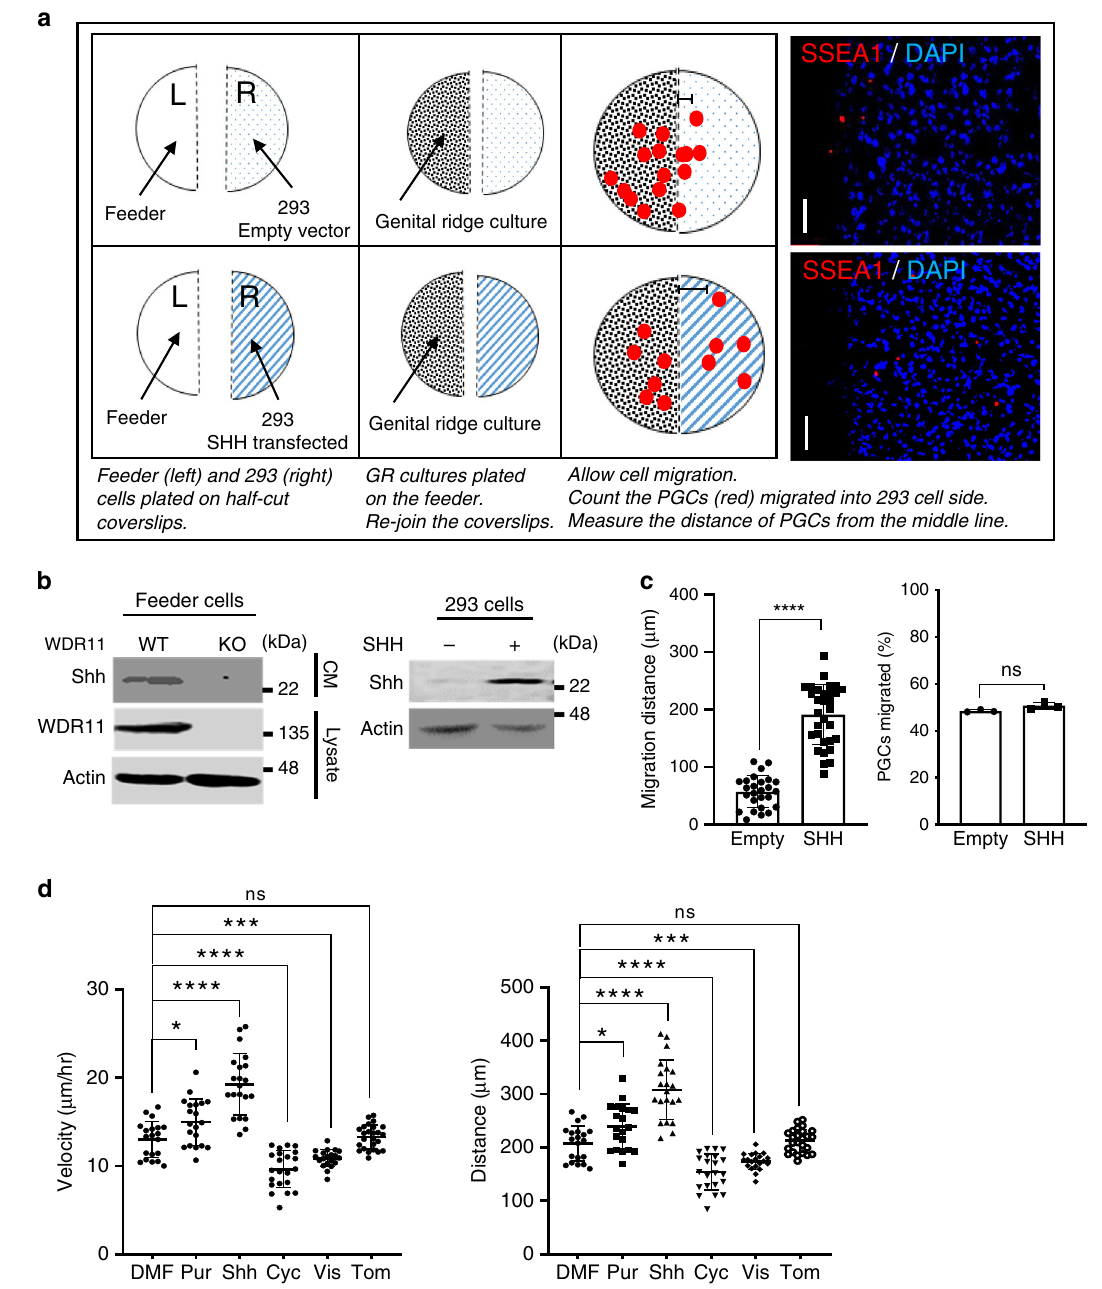
Fig. 2 Hh enhances PGC migration without chemoattraction. a Schematic representation of the chemotaxis assay. NIH3T3 cells deleted for the endogenous Wdr11 by CRISPR/Cas9, and therefore unable to secrete Shh, were used as the feeder. On average, ~30,000 cells of primary GR culture derived from fi ve embryos at E10.5 were plated on top of the feeder. For the source of Shh secretion, 293 cells transfected with a human full-length SHH expression construct were plated in comparison to the empty vector. After 24 h of incubation, cells on both sides of the coverslips were analysed by immuno fl uorescence. Scale bar, 50 μ m. b Western blot analyses validated Wdr11 KO feeder lacking Shh secretion in the conditioned medium (CM), while the transfected 293 cells producing Shh. B-actin is a loading control. Representative blots and cell images from three independent experiments are shown. c Total numbers of PGCs (SSEA + ) and their distance from the middle (the dotted line in a ) were assessed from ten random fi elds. Percentages of PGCs migrated towards the transfected 293 cells were similar in both groups, but the average distance of migration was signi fi cantly higher in SHH -expressing cells ( n = 35) compared with empty vector ( n = 30). Data are presented as mean ± SD from three independent experiments (**** P < 0.0001; NS, P > 0.05). d Intrinsic random motility of PGC was assessed by live time-lapse imaging (see Supplementary Movies 5 – 10). The average of velocity and accumulated moving distance of GFP-positive cells in random fi elds of view tracked for 16 h in three biologically independent experiments are shown. Data from solvent dimethyl formamide (DMF, n = 20), purmorphamine (Pur, n = 20), cyclopamine (Cyc, n = 22), visomodegib (Vis, n = 20) and tomatidine (Tom, n = 25) treatment groups are analysed using unpaired t -test with Welch ’ s correction (* P = 0.0111; *** P = 0.0003; **** P < 0.0001). Source data are provided as a Source Data fi